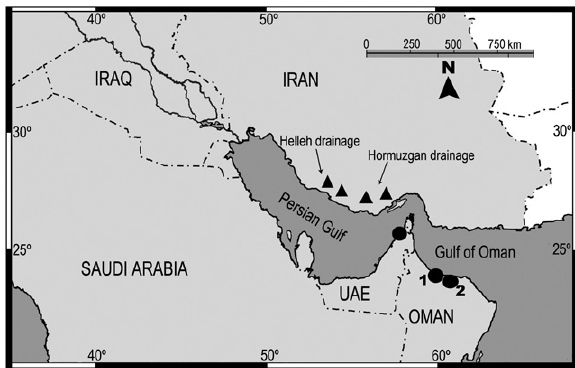
Fig . 2. – Map of sampling locations. Circles indicate coastal sites, triangles landlocked sites. 1 site 1 near Sib, Oman; 2 site 2 near Sib,